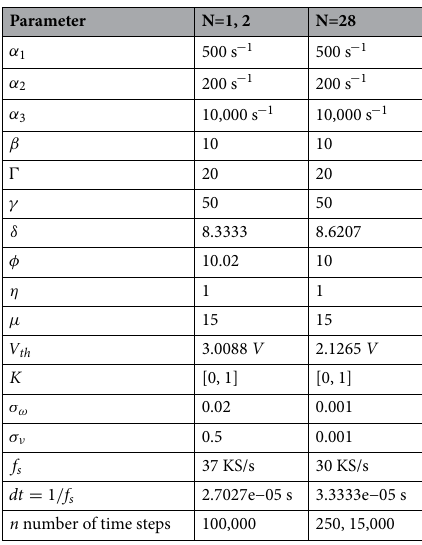
Table 1. Parameters used in the simulations of Eqs. (7a–c) for the isolated node, a couple of nodes and the network of 28 nodes configurations. These parameters correspond to those used in the experimental set-up presented in Refs. 39,41 ,